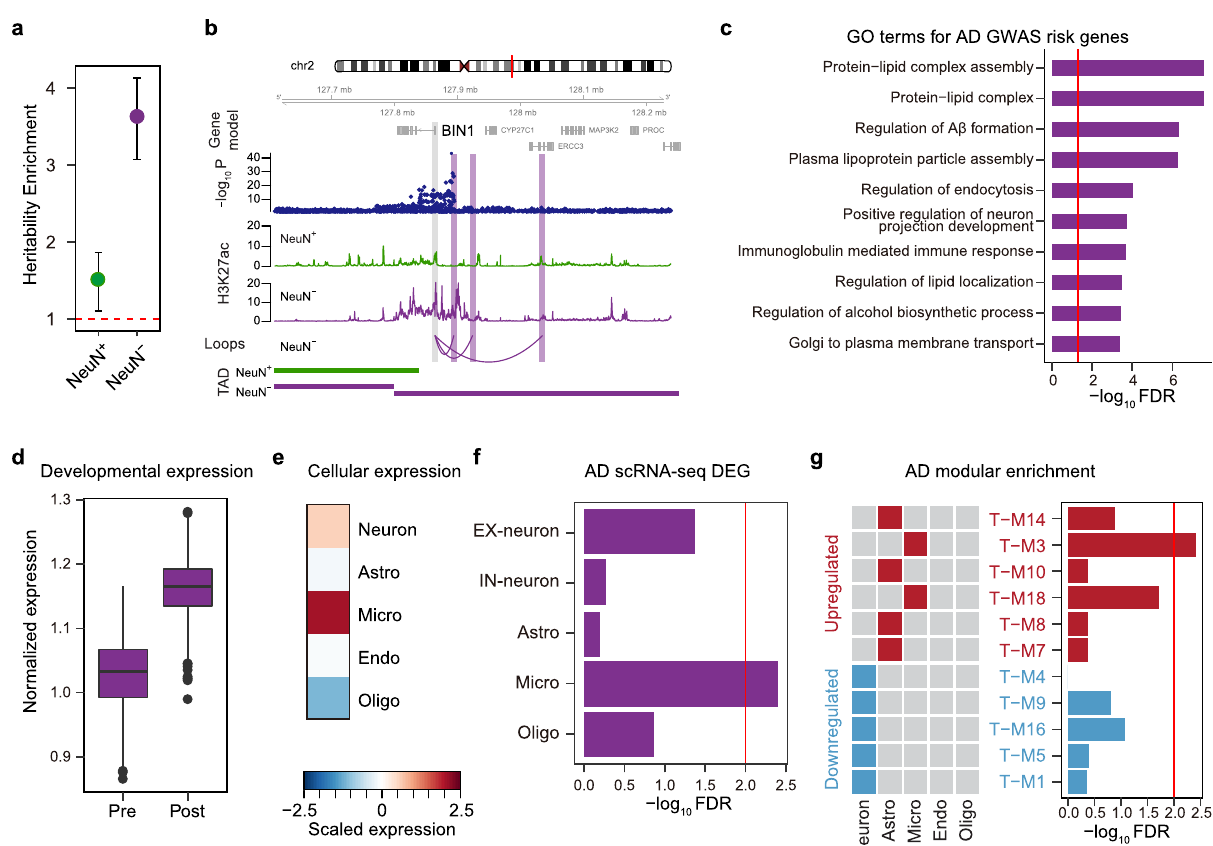
Fig. 4 Identi fi cation and characterization of putative target genes of AD genetic risk factors by incorporating NeuN − chromatin interaction. a The SNP-based heritability enrichment of AD GWAS in differential NeuN + and NeuN − peaks suggests glial enrichment. Enrichment ±standard error is depicted. The red broken line indicates heritability enrichment = 1. Source data are provided as a Source Data fi le. b BIN1 promoter physically interacts with an AD GWS locus in a NeuN − speci fi c manner. The regions that interact with BIN1 promoter (marked in gray) are highlighted in purple. c GO analysis for GWAS- guided AD risk genes identi fi ed by NeuN − H-MAGMA. The red line denotes FDR = 0.05. d AD risk genes are highly expressed in postnatal brain samples compared with prenatal samples. Pre prenatal ( n = 410); Post, postnatal ( n = 453). p = 6.93e − 193, calculated by Wilcoxon Rank Sum test. Center, median; box = Q1 – Q3; minima, Q1 − 1.5 × IQR; maxima, Q3 + 1.5 × IQR. Source data are provided as a Source Data fi le. e AD risk genes are highly expressed in microglia. f AD risk genes are signi fi cantly enriched for genes differentially regulated in AD microglia. Fisher ’ s exact test was used for statistics analysis. The red line denotes FDR = 0.01. g AD risk genes are enriched in a microglial co-expression module that is upregulated in AD. Fisher ’ s exact test was used for statistical analysis. The red line denotes FDR = 0.01. Astro astrocytes, Micro microglia, Endo endothelial, Oligo